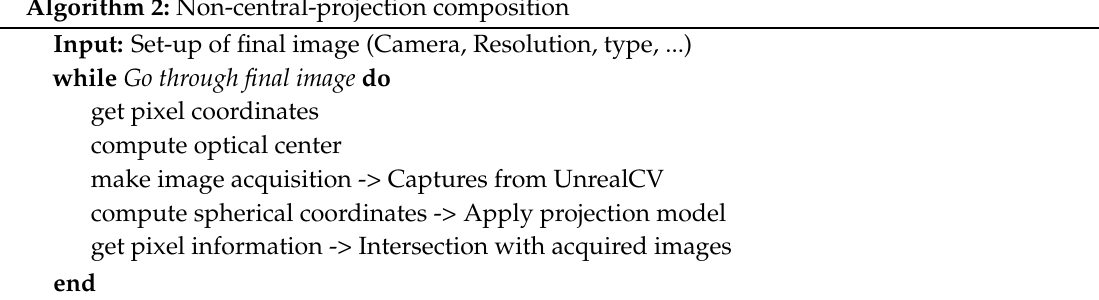
Algorithm 2: Non-central-projection